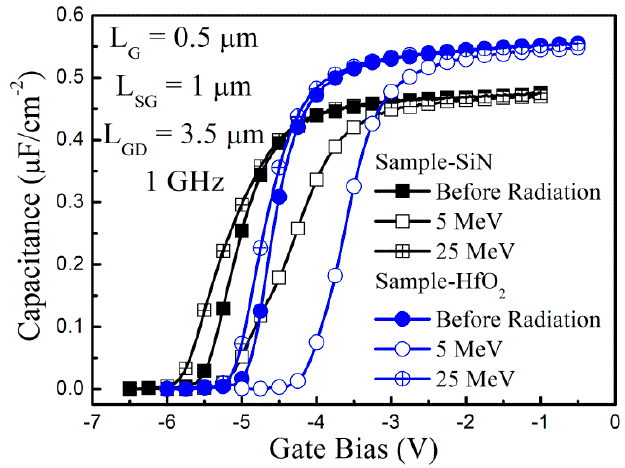
Figure 4. Capacitance-voltage measurement results before and after proton irradiation in GaN-based MIS-HEMTs for the 5 nm-thick Si 3 N 4 and the HfO 2 gate insulator.